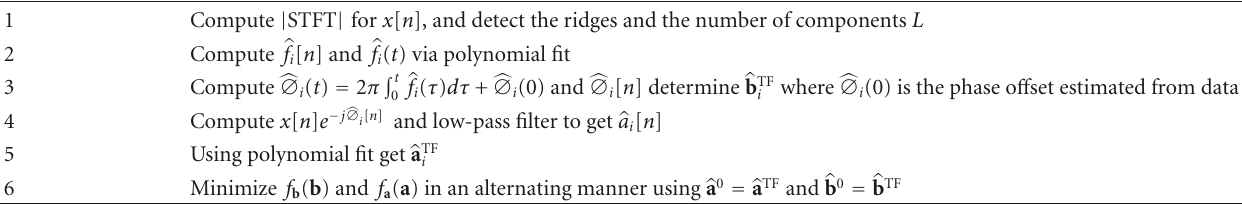
Table 1: The proposed alternating phase and amplitude (APA) algorithm.